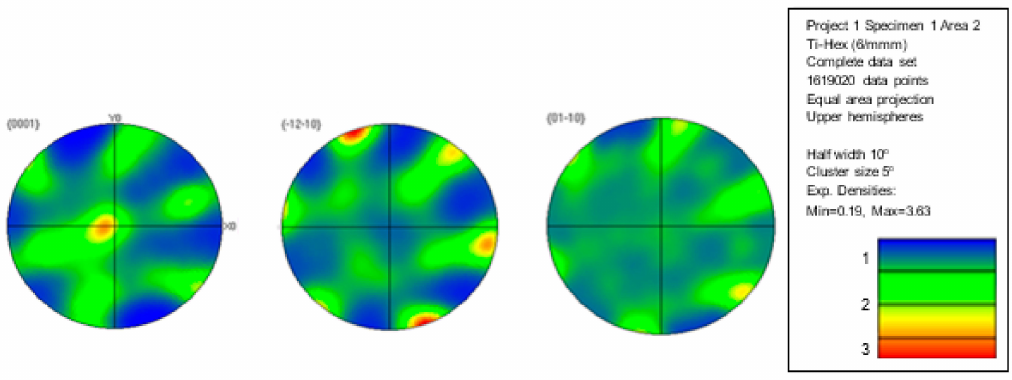
Figure 13. EBSD pole figures associated with Figure